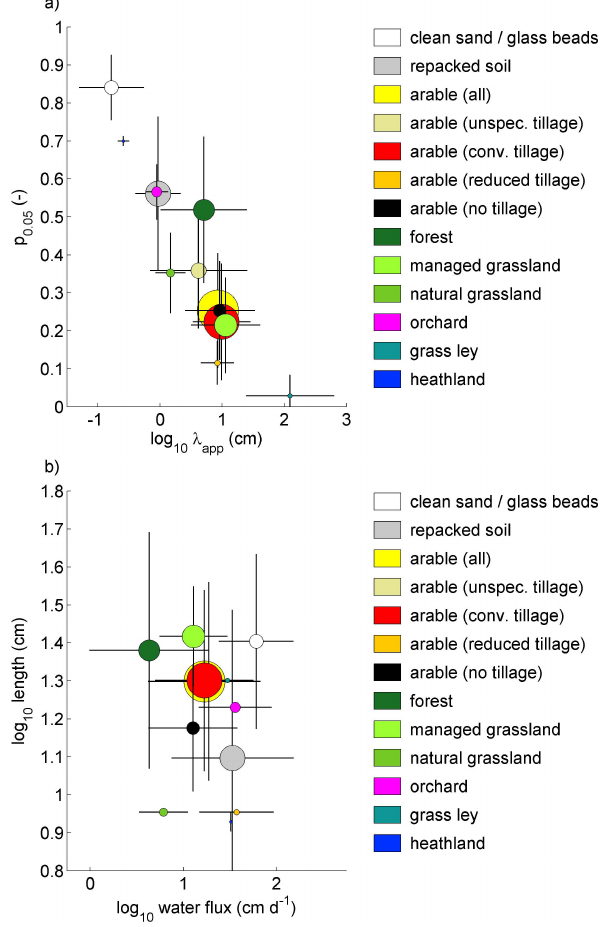
Fig. 10. (a) Comparison of the apparent dispersivity, λ app , and normalized 5%-arrival time, p 0 . 05 , with the respective land use; (b) comparison of the water flux, q , and column length, L , with the respective land use. The center of each circle depicts the respective median value, and the error bounds indicate the corre- sponding interquartile range. The size of each circle corresponds to the number of samples within each land use